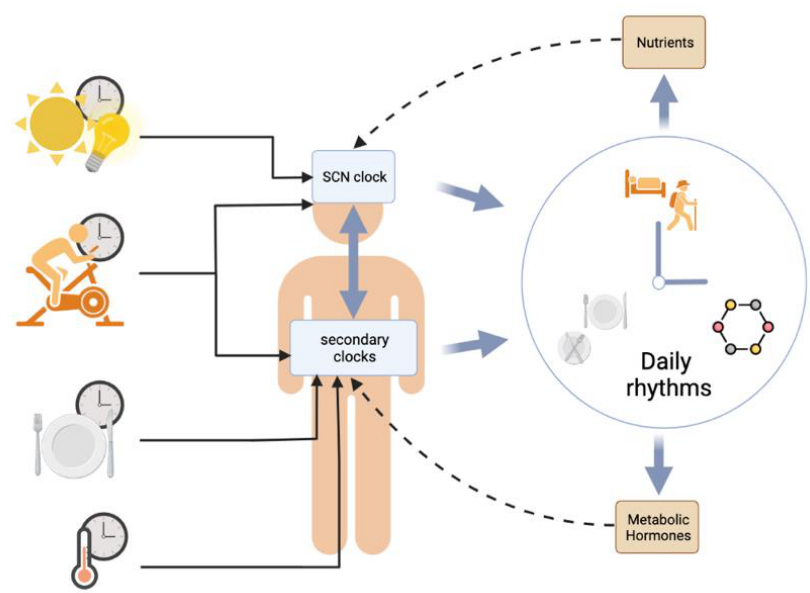
Figure 3. Schematic representation of the reciprocal connections between food intake/metabolic energy and circadian clocks. The main circadian clock, located in the suprachiasmatic nuclei of the hypothalamus (SCN), and the peripheral clocks (brain and peripheral organs) are synchronized by the daily timing of ambient light (SCN), physical activity (SCN and peripheral clocks), meals, and temperature (peripheral clocks). The internal synchronization between these different clocks takes place, producing different daily rhythms such as the sleep–wake cycle, the feeding–fasting cycle, and hormonal rhythms. These rhythms also participate in the regulation of the different clocks, notably through metabolic hormones and nutrient requirements. Created with https://www.biorender.com/ (accessed on 10 February 2023).